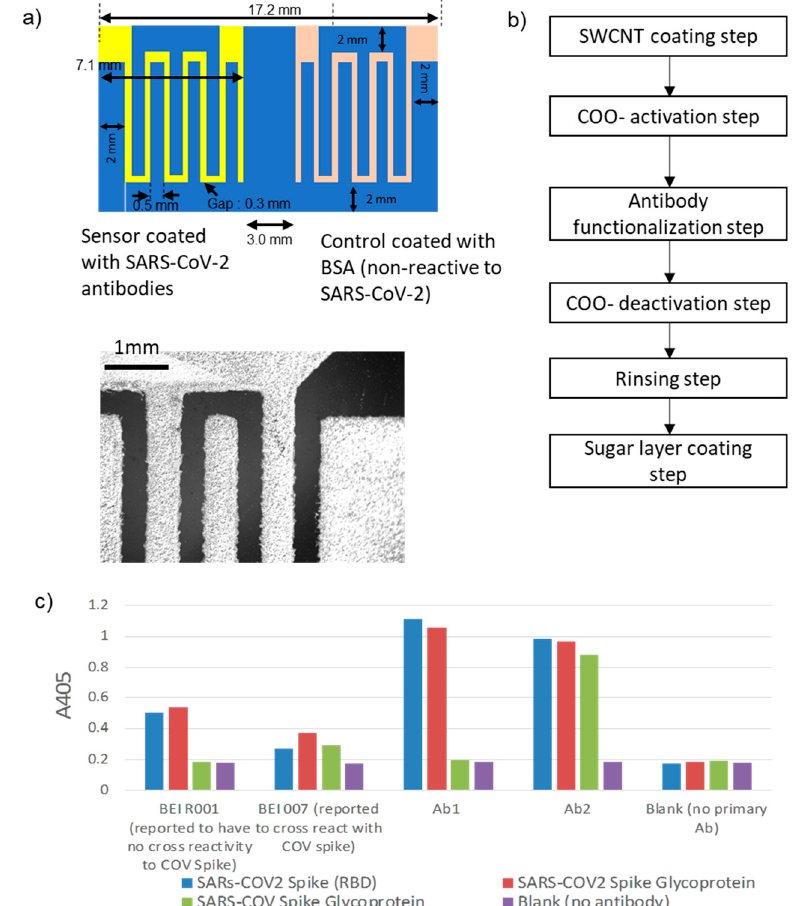
Figure 3. ( a ) Sensor configuration. Sensor electrodes are coated with SARS-CoV-2 antibodies. Control electrodes are with BSA. ( b ) Antibody functionalization step on SWCNTs. ( c ) Specificity test results to SARS-CoV and SARS-CoV-2 of antibodies using ELISA.